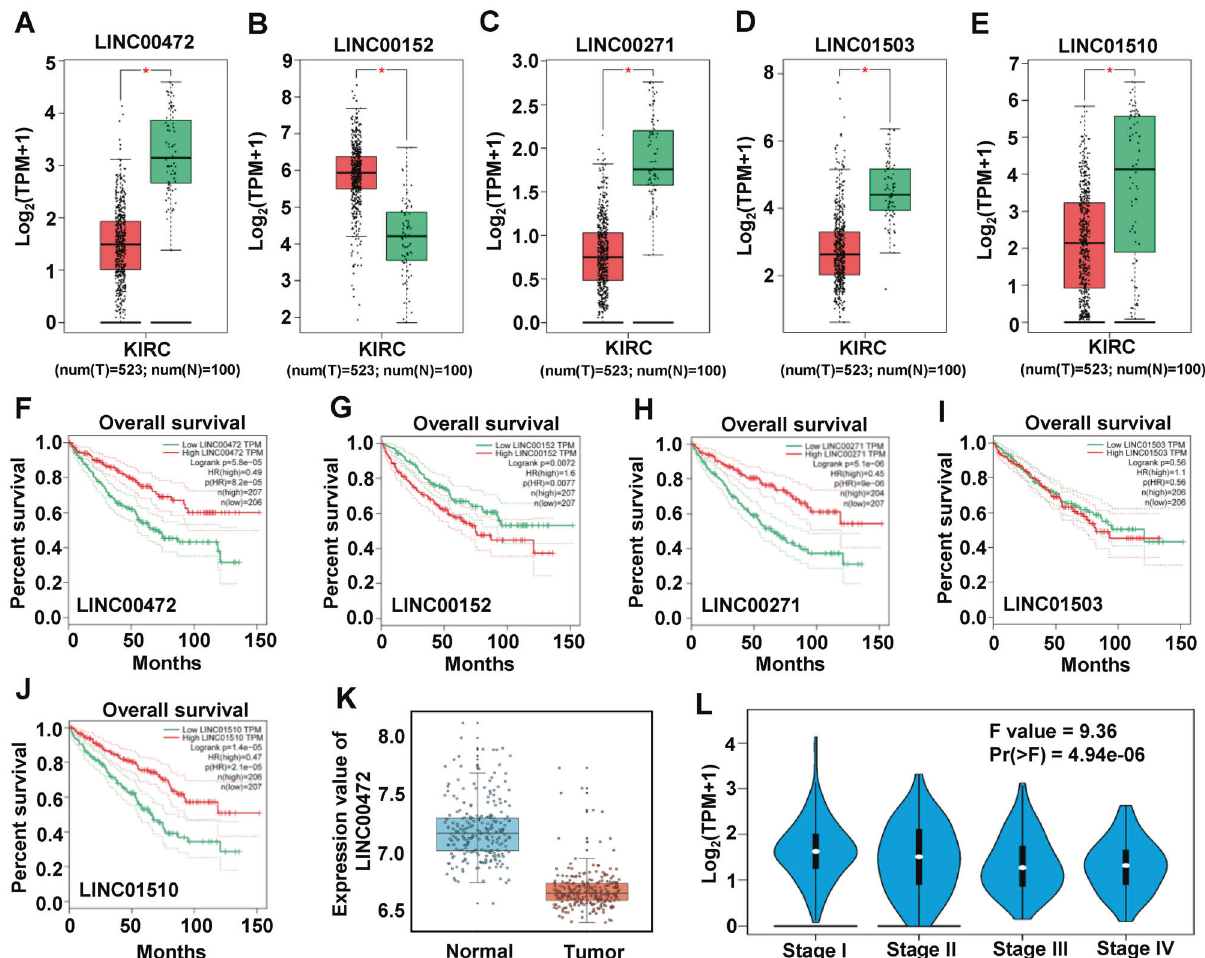
Fig. 2 LINC00472 is low expressed in RCCC and is related to the prognosis of patients. Expression of LINC00472 ( A ), LINC00152 ( B ), LINC00271 ( C ), LINC01503 ( D ), and LINC01510 ( E ) of TCGA RCCC samples, red represents tumor group and green represents normal group. F – J Relationship between the levels of expression of LINC00472 ( F ), LINC00152 ( G ), LINC00271 ( H ), LINC01503 ( I ), and LINC01510 ( J ) and the prognosis of patients (OS time). K Expression of LINC00472 in GSE44055 datasets. L Expression of LINC00472 in TCGA RCCC samples with different tumor